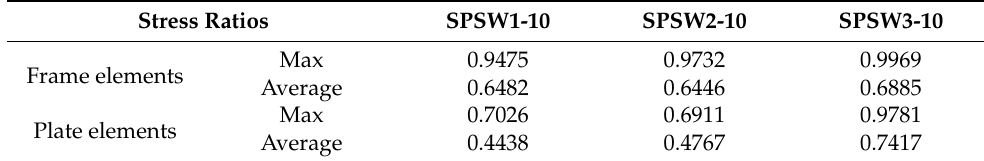
Table 10. Maximum and average stress ratios of frame and plate elements for 10-story steel